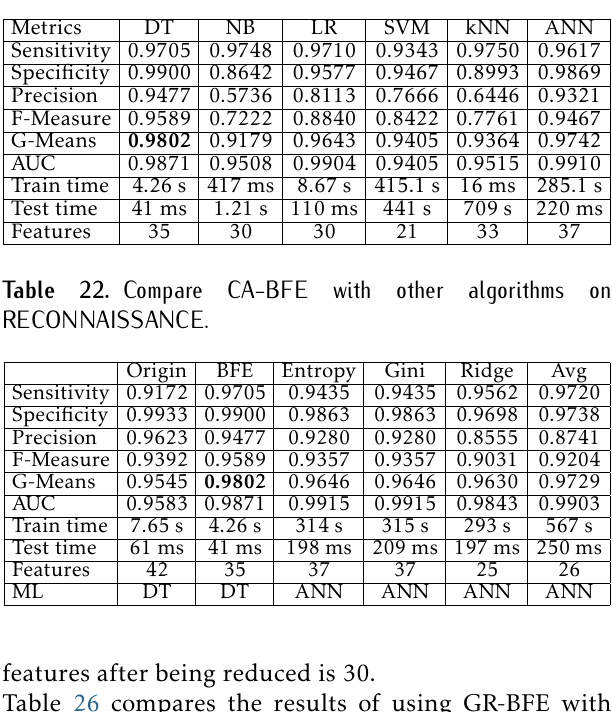
Table 16. Results of using GR-BFE algorithm on ANALYSIS.